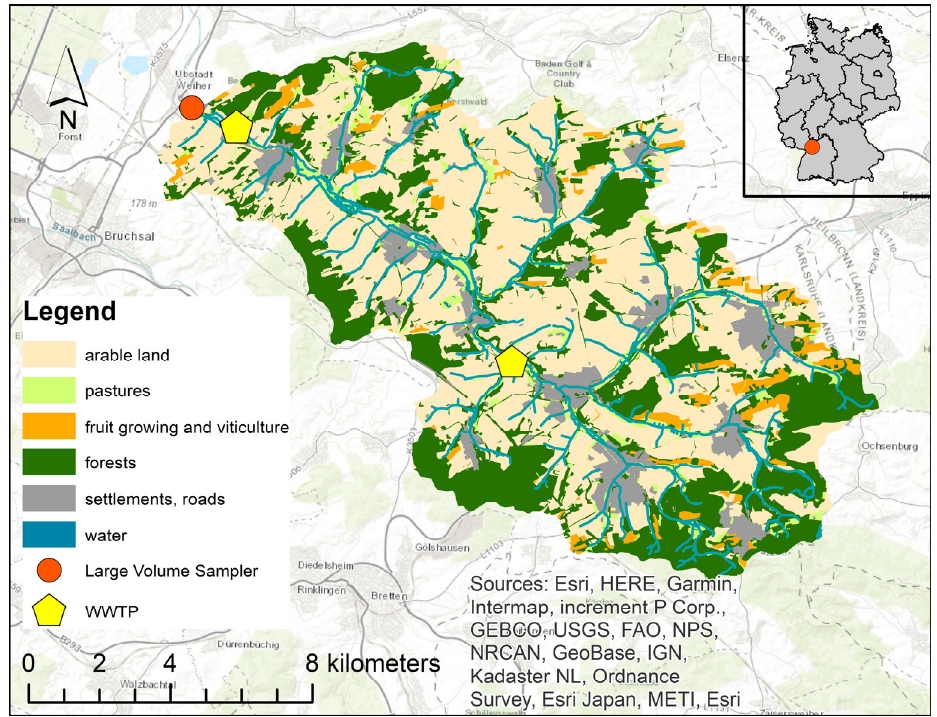
Figure 1. Land use in the Kraichbach study area.